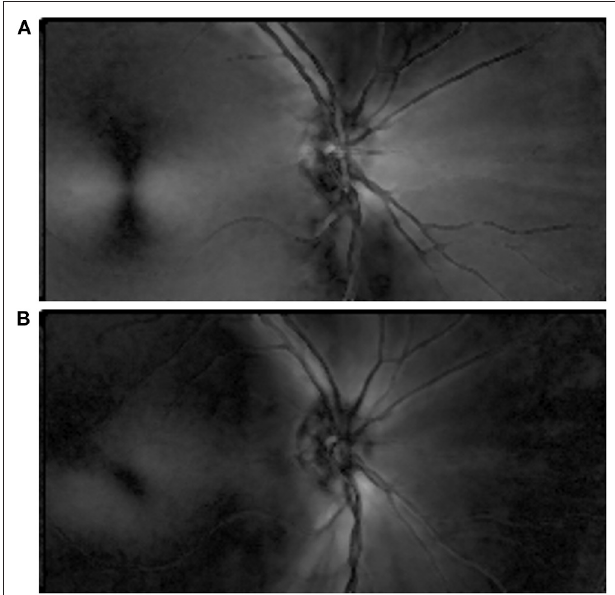
FIGURE 3 | Phase retardation distribution map in 20 ◦ × 40 ◦ scanning laser polarimetry image. (A) An image acquired from a subject in the first cohort included a fixed polarization element that partially compensated for corneal birefringence. Due to incomplete compensation, a characteristic macular cross pattern resulted, centered on the macula. (B) An image acquired from a subject in the second cohort included a variable polarization element that more fully accounted for corneal birefringence than a fixed-compensation setting. It manifested an annulus, centered on the macula.